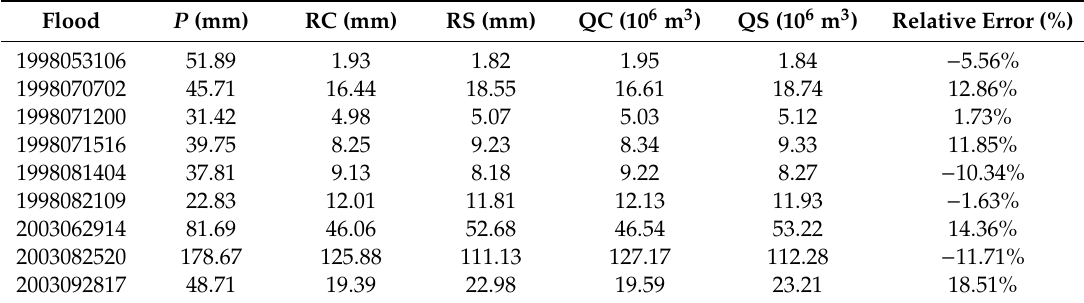
Figure 10. CN distribution in different regions in different periods. Table 10. Rainfall-runo ff simulation. Table 12. Runoff from SCS model in different districts in different periods (10 6 m 3 ).